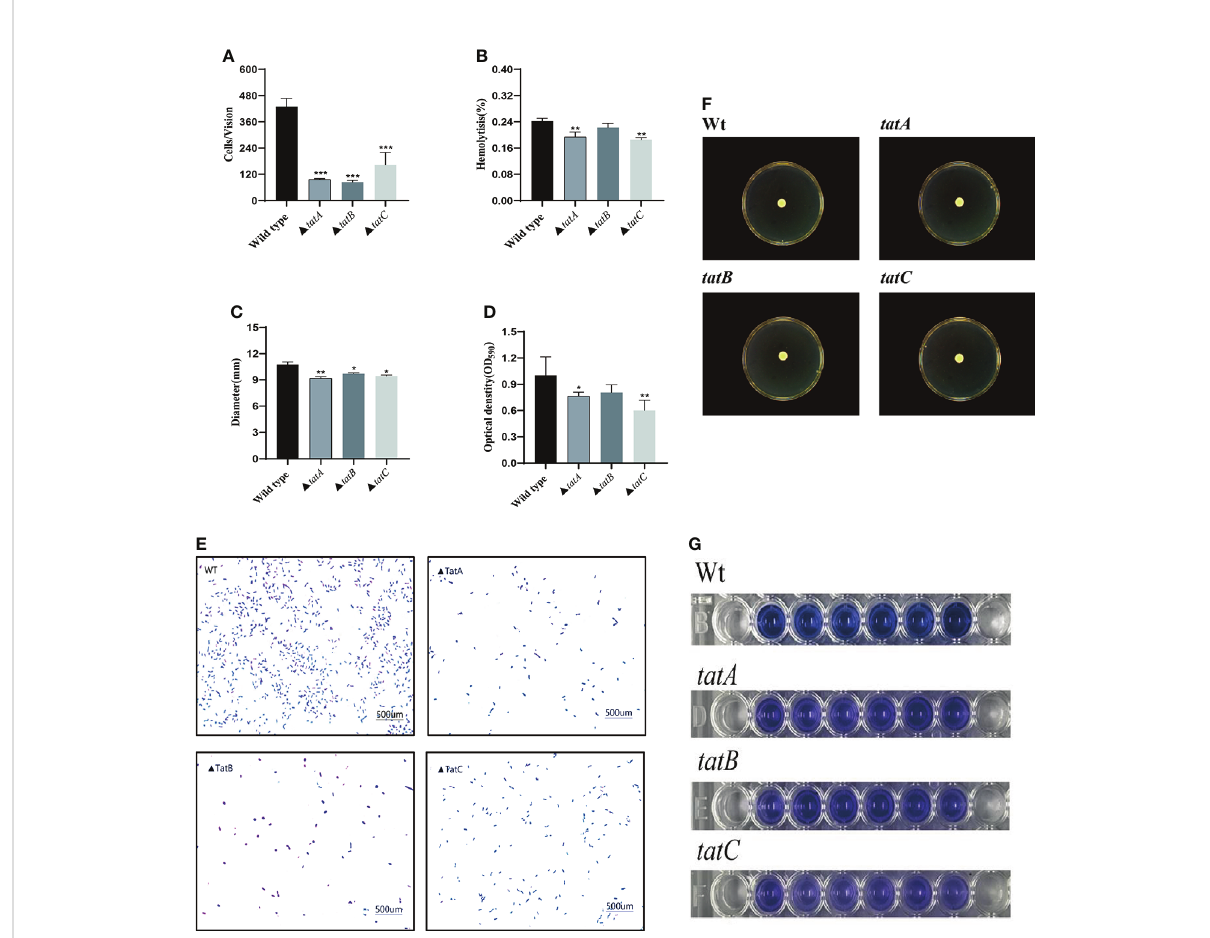
FIGURE 10 Characteristics of wild type, D tatA , D tatB , and D tatC mutants. Adhesion capacity (A) , hemolytic capacity (B) , motility (C) , and bio fi lm formation (D) , The effect on the adhesion ability of grouper mucus (E) , Motion phenotype (F) , biomembrane phenotype (G) were measured. Data are presented as mean ± SD. Three independent biological replicates were performed for each group. * P < 0.05, ** P <